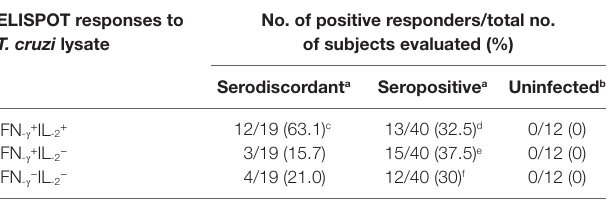
TaBle 3 | Cytokine-secreting T cells in response to a T. cruzi lysate in subjects with discordant, positive, or negative findings by conventional serological techniques living in non-endemic